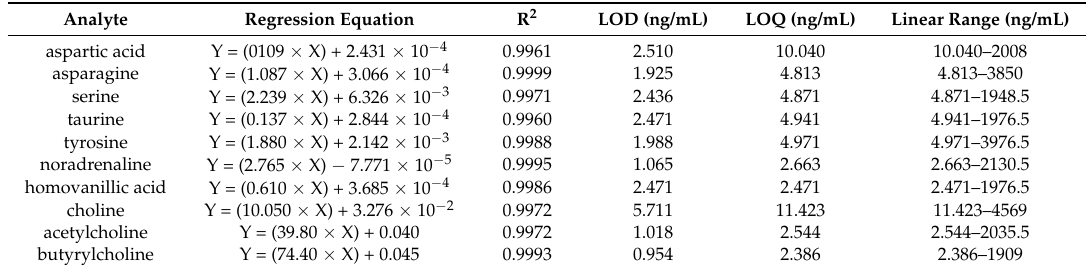
Table 4. Regression equations, correlation coefficient, detection limits, and linear range of 10 neurotransmitters.